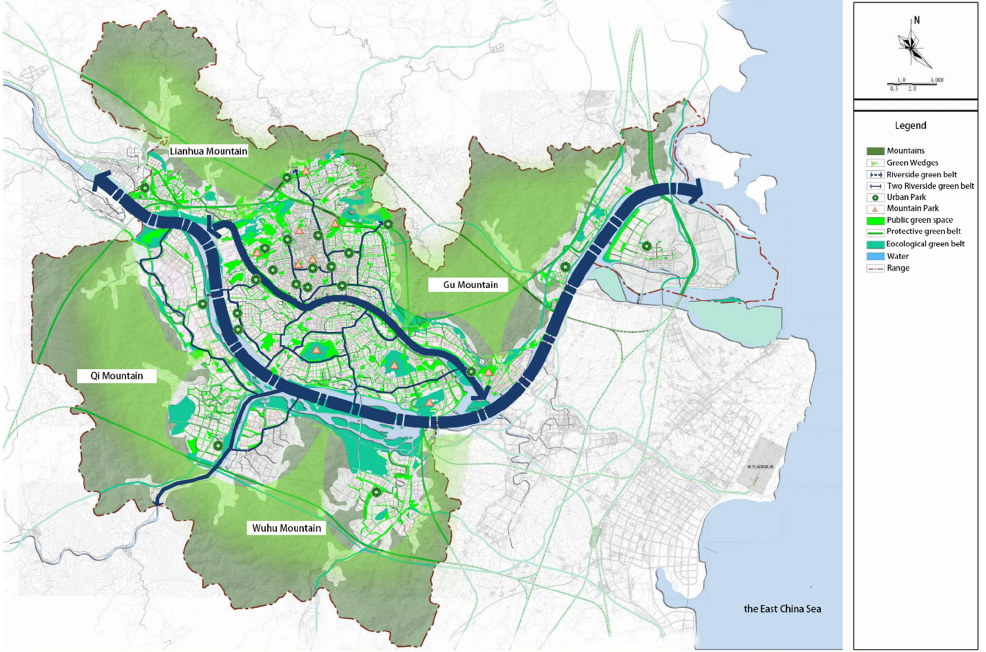
Figure A1. Planning diagram of green space system in Fuzhou city center (2011–2021).